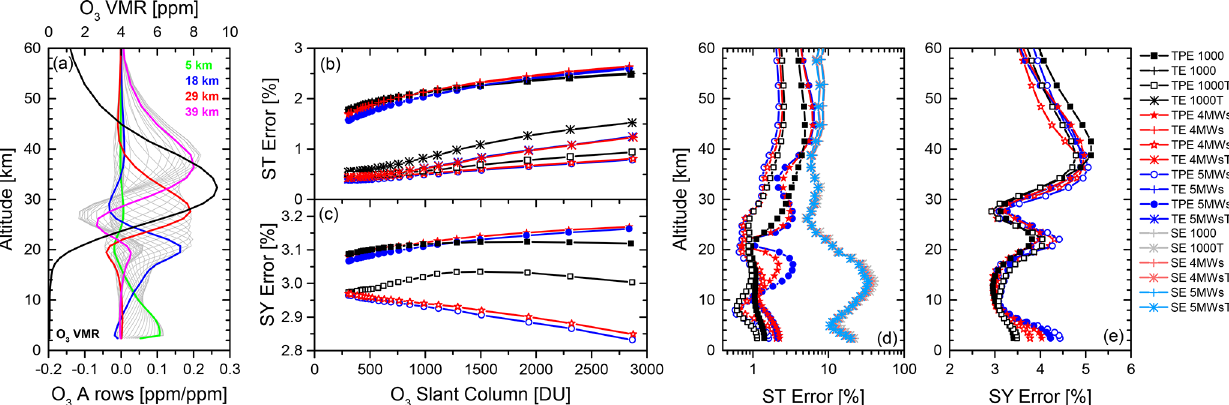
Figure 3. Summary of the theoretical quality assessment. (a) Example of averaging kernel ( A ) rows for the 5MWs setup on a logarithmic scale for the measured spectrum of Fig. 2. Coloured lines highlight the A rows at altitudes of 5, 18, 29, and 39km, which are representative of the four layers detectable by the FTIR instrument (total DOFS of 4.41). The retrieved O 3 VMR profile is also shown. (b) Statistical (ST) and (c) systematic (SY) contributions of the total parameter error (TPE, in %) and total error (TE, in %) for O 3 TCs retrieved from the setups 1000/1000T, 4MWs/4MWsT, and 5MWs/5MWsT as a function of O 3 slant column (DU) for measurements taken on 31 August 2007 from SZAs between 84 ◦ ( ∼ 07:00UT) and 21 ◦ ( ∼ 13:30UT). TPE is computed as the square root of the quadratic sum of all ST and SY error sources considered with the exception of the smoothing error (SE), while the TE considers the TPE and SE. Examples of the ST (d) and SY (e) contributions of the TPE and SE profiles (%) for all setups for the measured spectrum of Fig. 2. Table 1. Summary of statistics of the DOFS and fitting residuals for the setups 1000/1000T, 4MWs/4MWsT, and 5MWs/5MWsT for the periods 1999–2004, 2005–May 2008, and June 2008–2018 and for the entire time series (1999–2018). Shown are the median ( M ) and standard deviation ( σ ) for each period. The number of quality-filtered measurements is 519, 745, and 4219 for the three periods, respectively, and 5393 for the whole dataset. The strategies showing the best performance, in terms of largest DOFS and smallest residuals, are highlighted in bold for each period. Setup